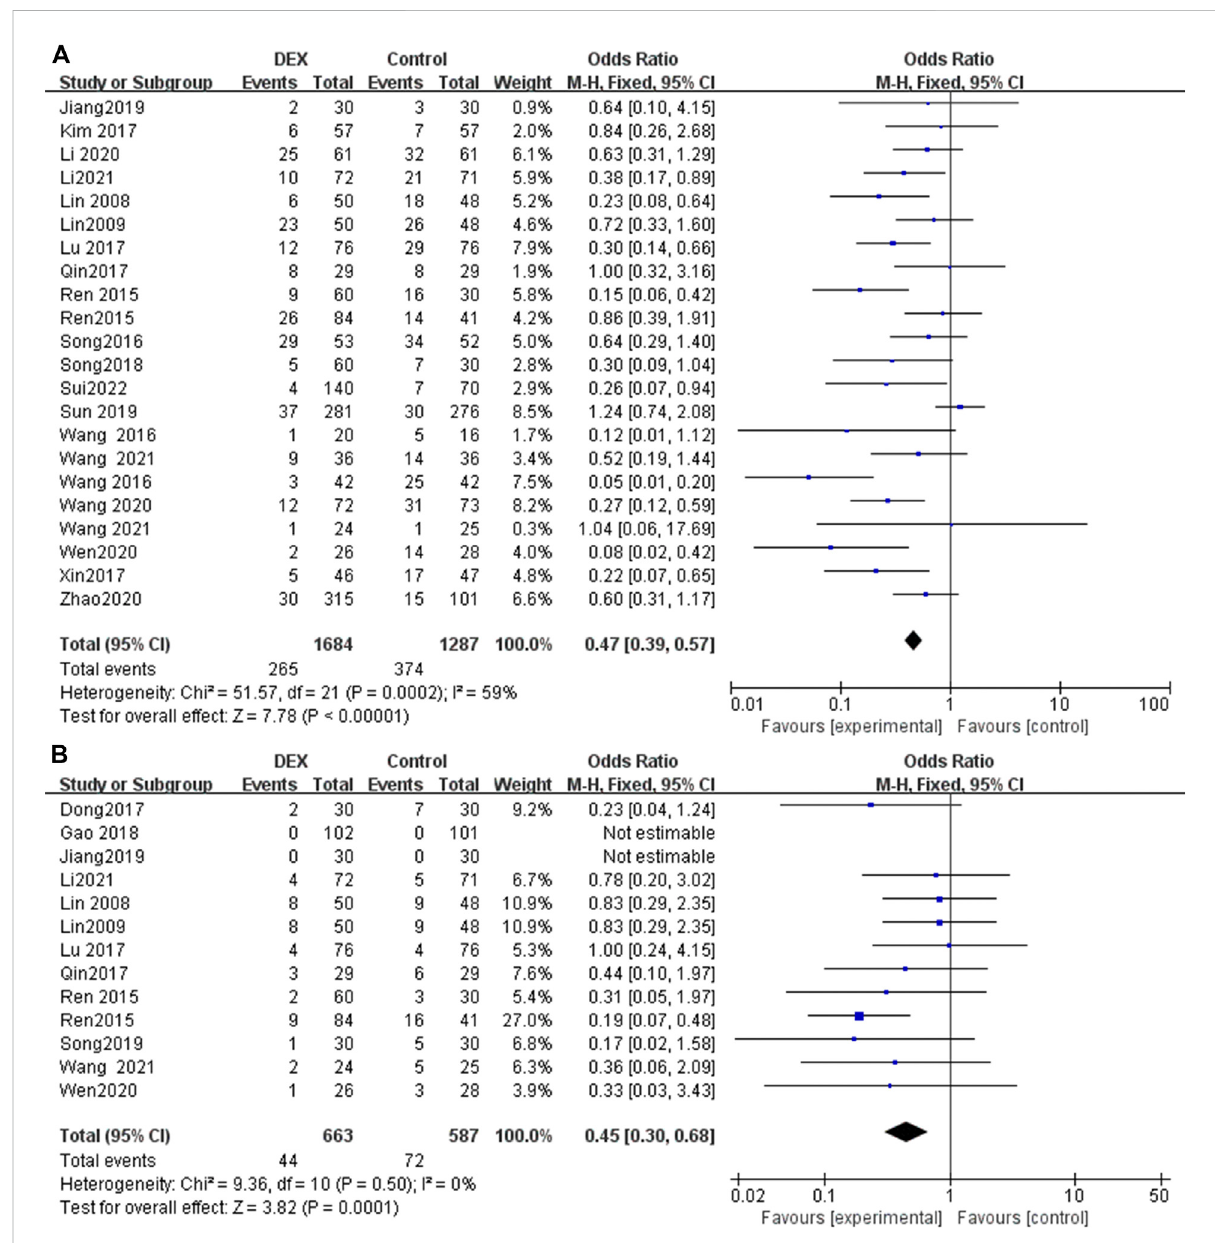
FIGURE 6 Forest plot for adverse reactions in postoperative PCIA patients. (A) Postoperative nausea and vomiting (PONV), (B) Pruritus after surgery,